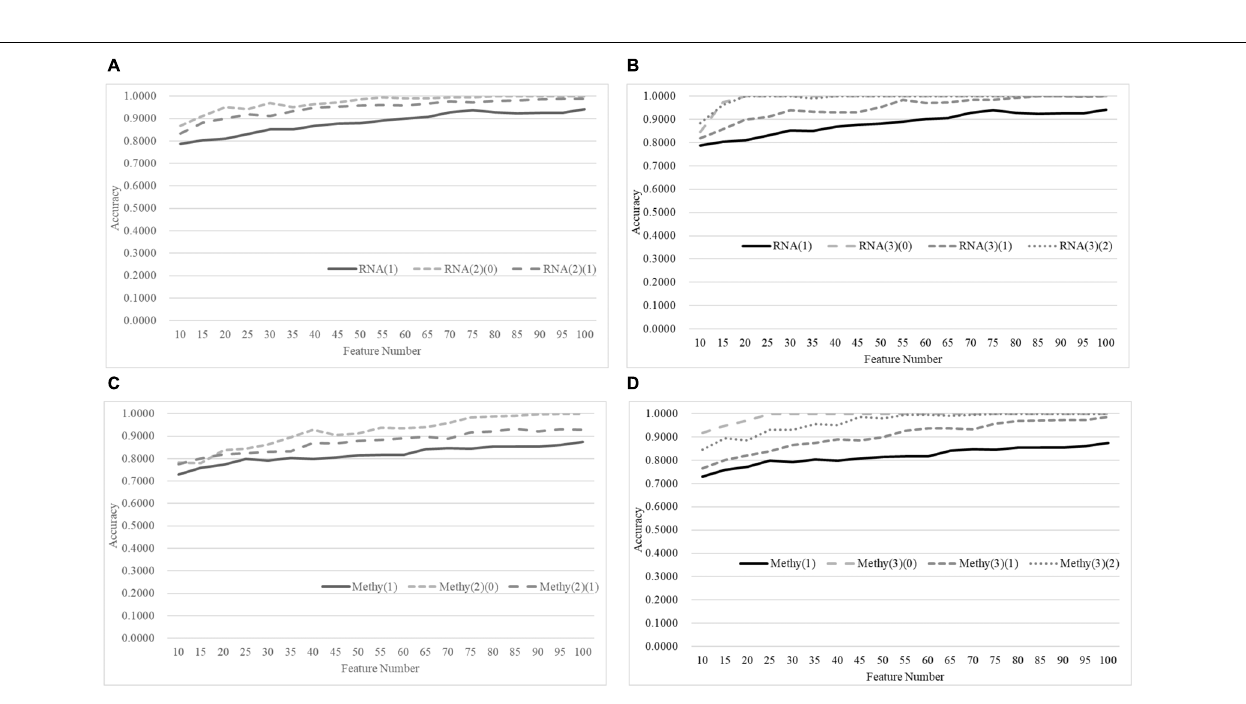
FIGURE 9 | Comparison of early-stage breast cancer detection models with different age groups based on both transcriptome and methylome data using the classifier SVM on the independent test datasets. Transcriptomes of the patients were split into (A) two groups and (B) three groups with equally-sized age ranges. The methylomes were split into (C) two groups and (D) three groups in the same way. The horizontal axis shows the numbers of features chosen by rfeSVM, and the vertical axis shows the accuracy of the classifier SVM on the independent test dataset. F -test was used to generate the initial subset of 1000 top-ranked